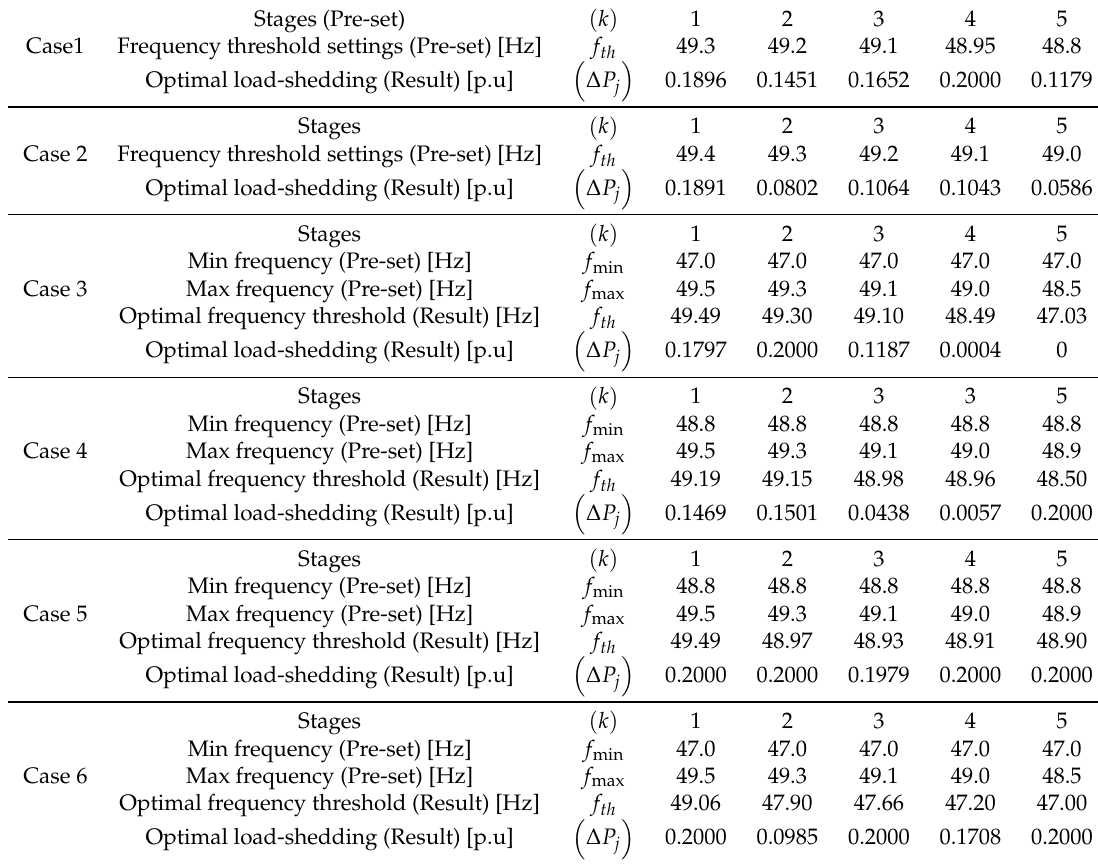
Table 3. Different simulation cases considered in this paper with upper/lower values of the